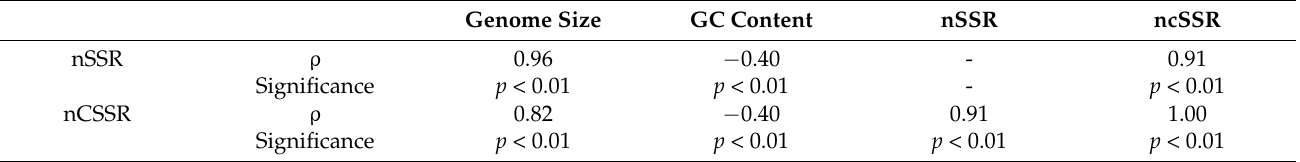
Table 2. Pearson analysis between nCSSR and genome size, GC content, nSSR, and